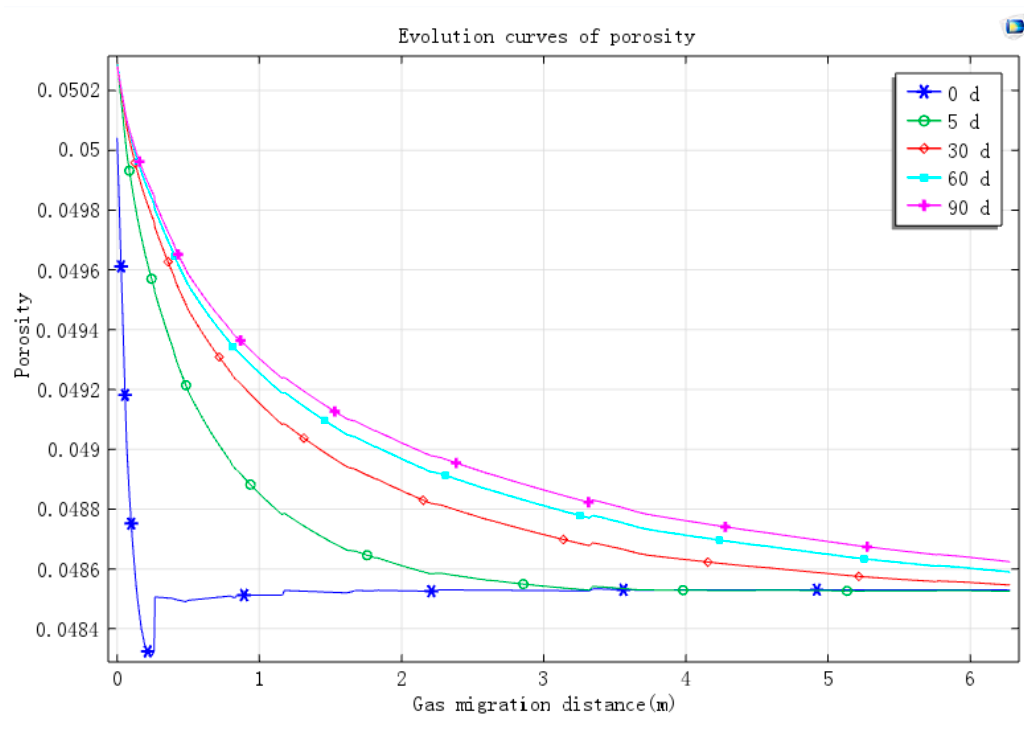
Figure 9. Evolution curves of permeability.